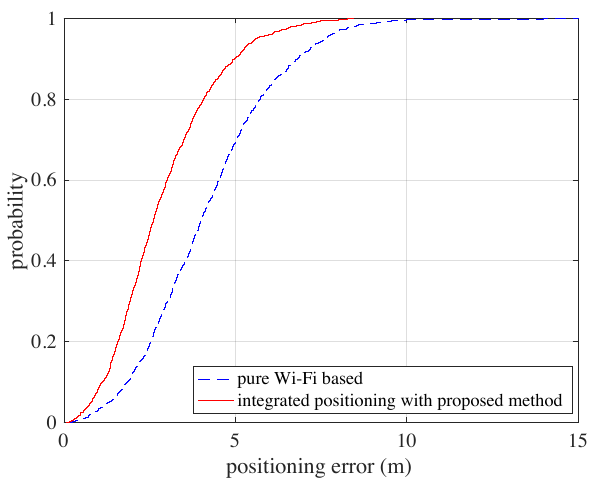
Figure 8. The Cumulative Density Function (CDFs) comparisons between pure Wi-Fi based positioning and the integrated positioning using the proposed methodology.